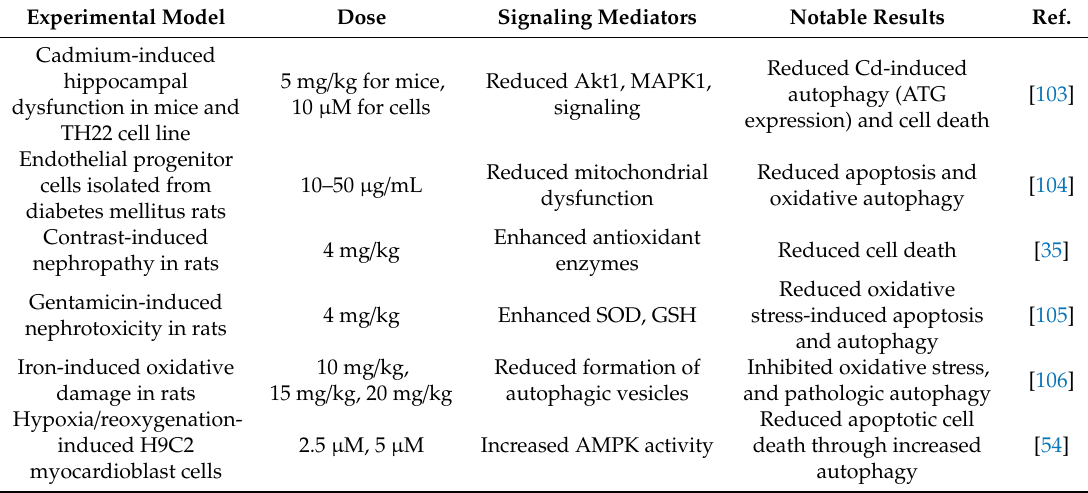
Table 1. The e ff ect of lycopene on signaling pathways that modulate